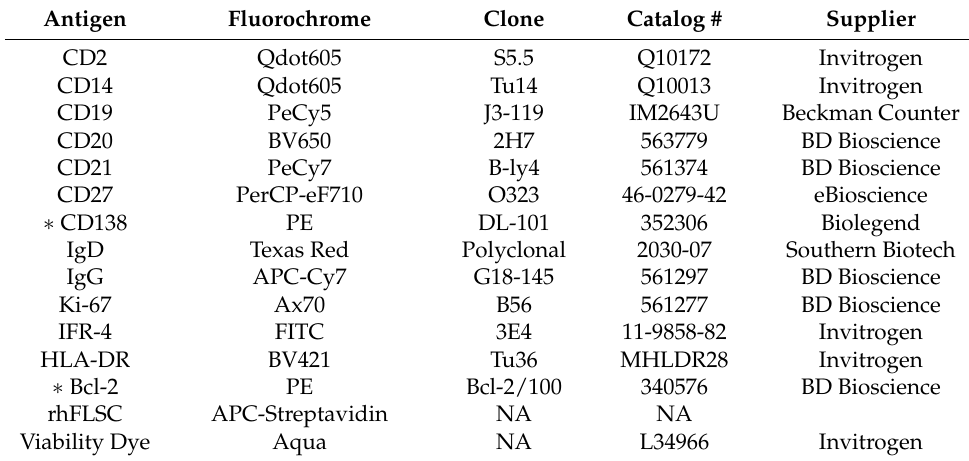
Table 2. Antibodies used for B-cell Flow